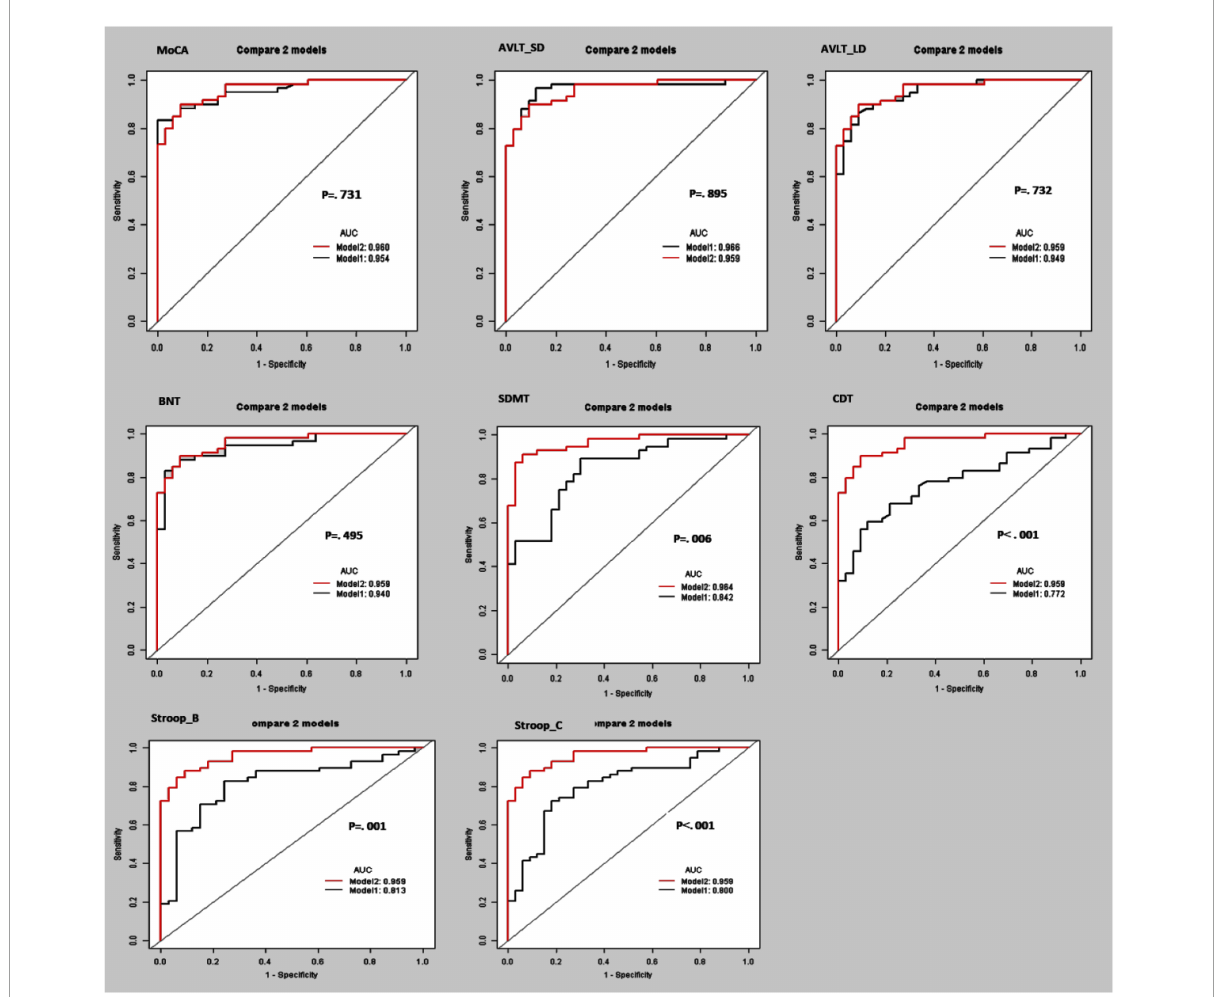
FIGURE3 Receiver operating curve (ROC) curves and area under the ROC curve (AUC) of the multi-kinematic parameters (Model 2) when compared to neuropsychological tests (Model 1) to separate amnestic mild cognitive impairment (aMCI) from cognitive normal elderly.